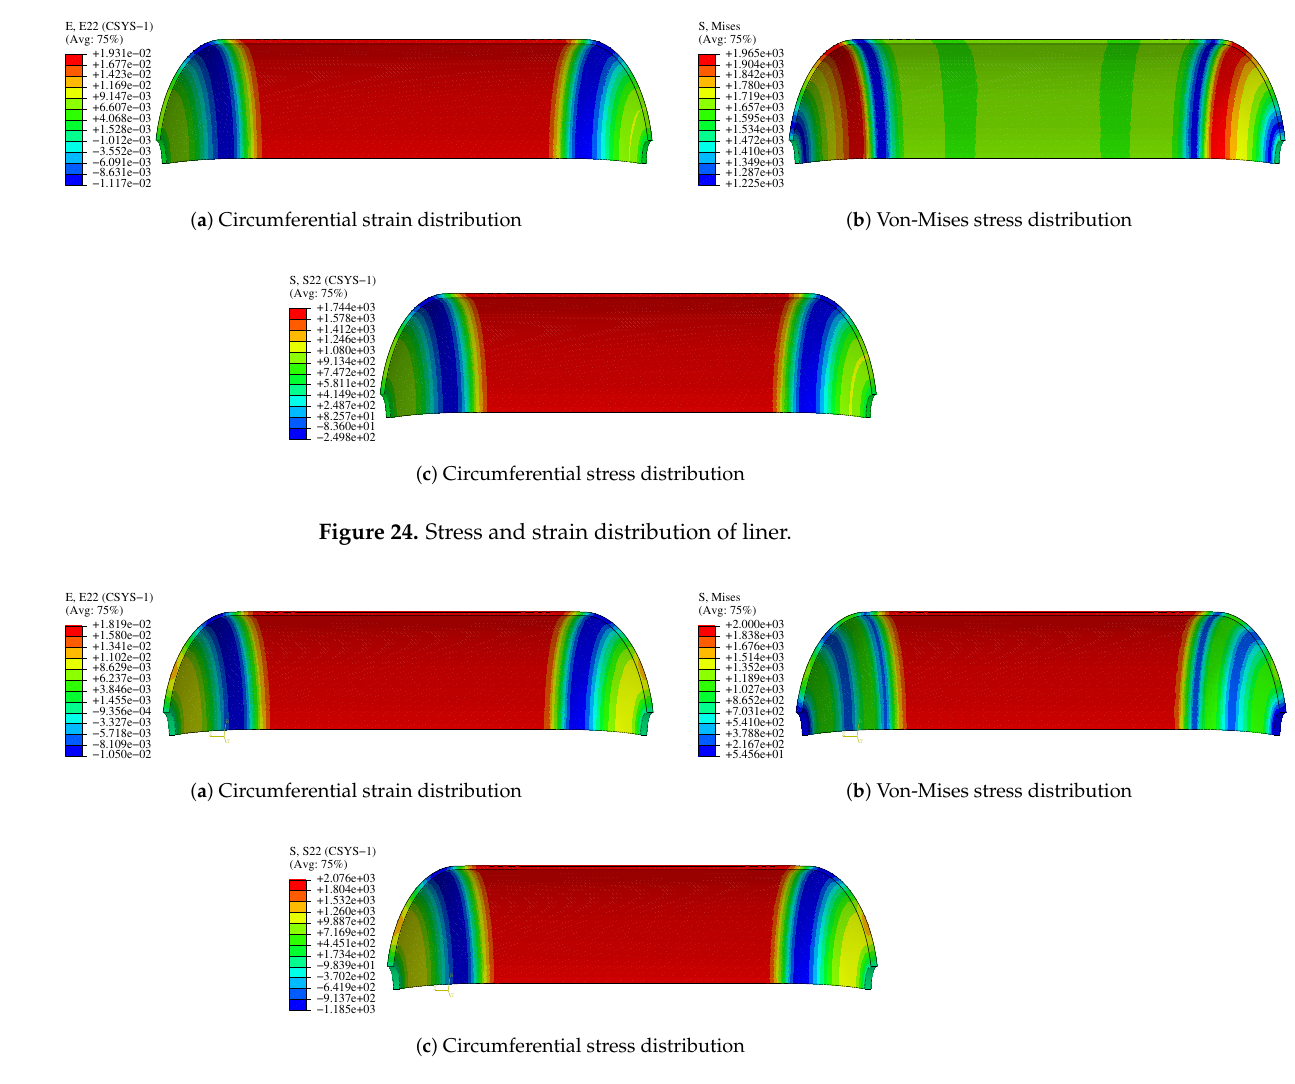
Figure 25. Stress and strain distribution of